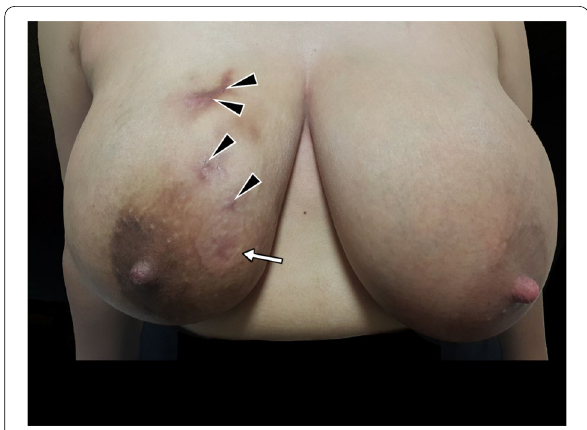
Fig. 2 A 26-year-old female patient. Fistula orifices in the right breast (arrowheads) and erythema of the breast skin (arrow)